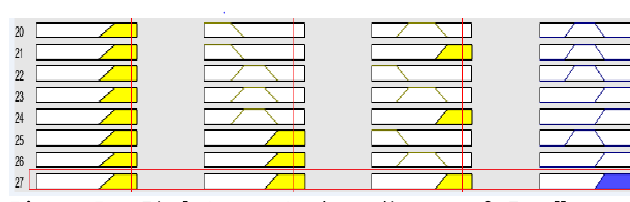
Figure 5c . Final Layer, Lookup diagram of Excellent Governance for proposed OGF-SCT-HMT-1-F Expert